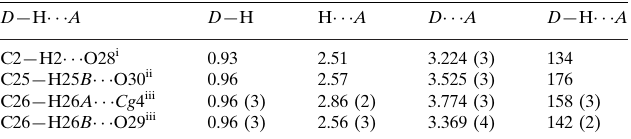
Hydrogen-bond geometry (A˚ , (cid:4) ). Cg 4 is the centroid of the C18–C23 ring.